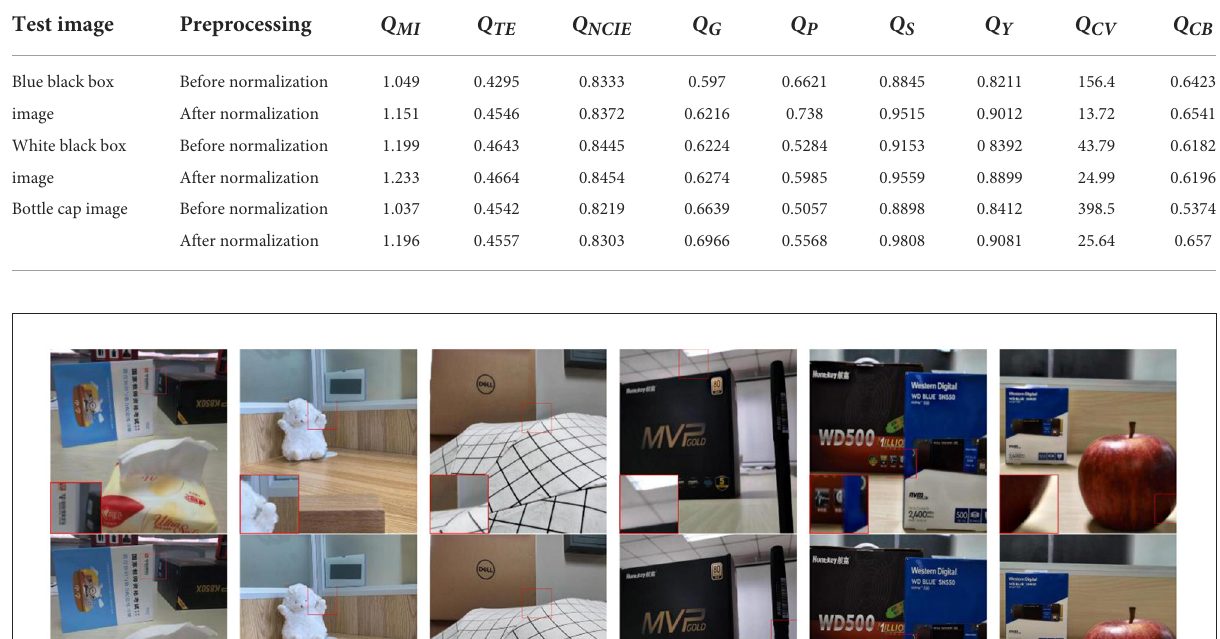
TABLE 3 The nine metrics’ values of the fused images before and after standardization of the image basic attribute.